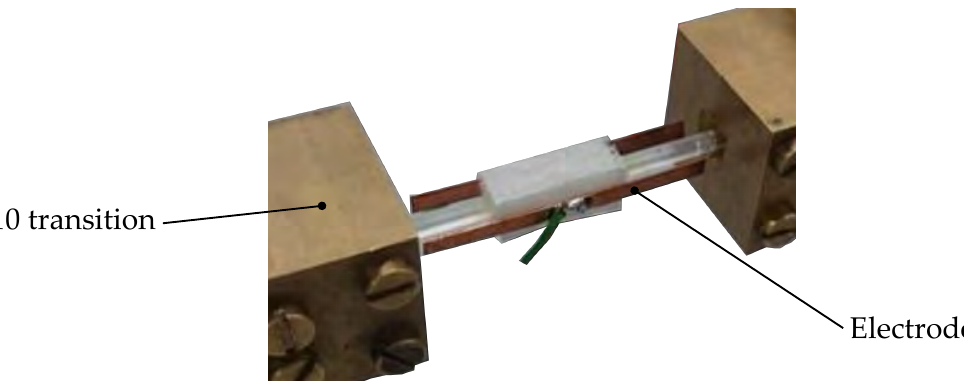
Figure 27. Measurement setup of the subwavelength fiber phase shifter.